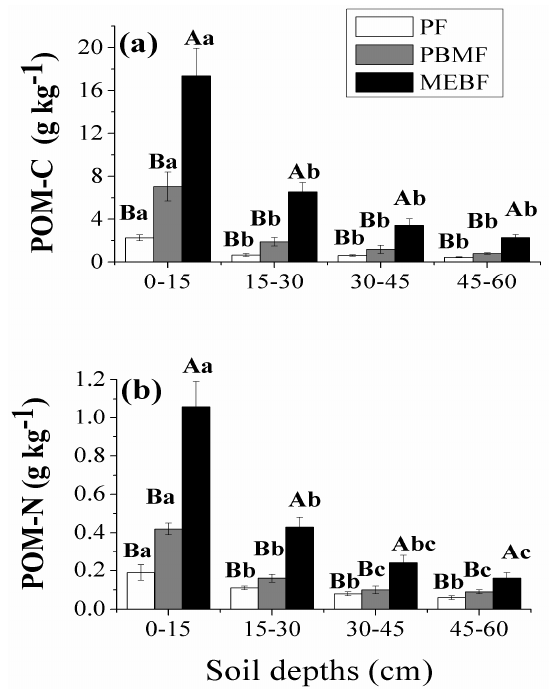
Figure 3. The concentration of particulate organic matter carbon (POM-C) (a) and nitrogen (POM-N) (b) from the whole soil in the three forests. Different uppercase letters indicate significant differences between different forests at p < 0.05. For the same forest and particulate organic matter (POM) fraction, different lowercase letters indicate significant differences between depths at p < 0.05. PF: pine forest; PBMF: pine and broadleaved mixed forest; MEBF: monsoon evergreen broadleaf